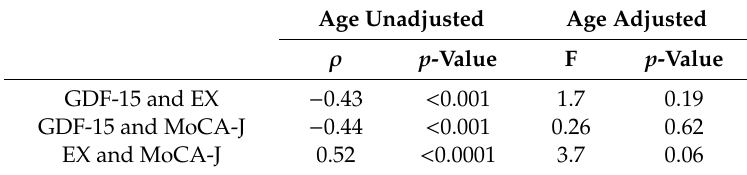
Table 3. Association of EX, MoCA-J, and GDF-15 unadjusted and adjusted by age in all